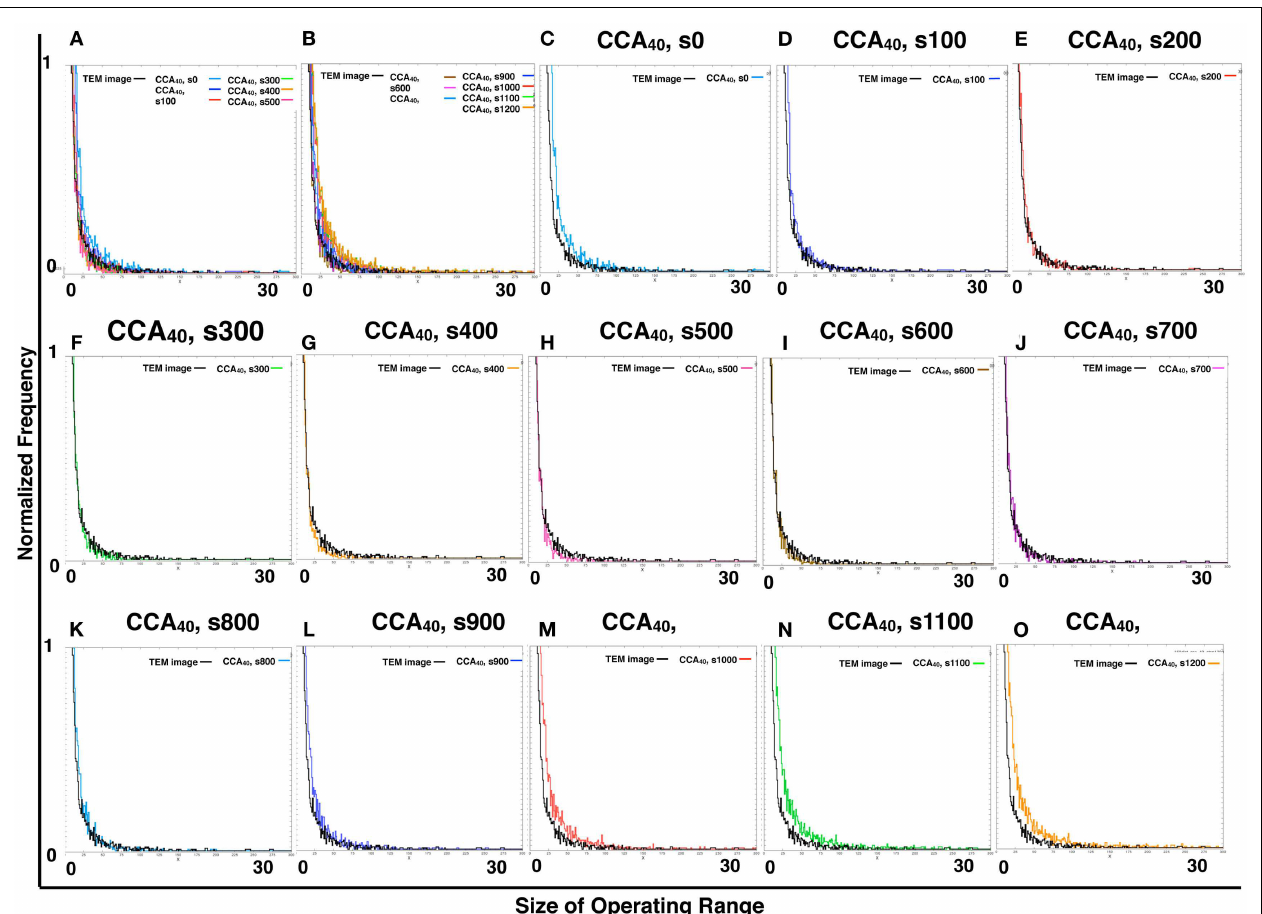
the size distribution of the operating range ofTEM images (black lines). x -Axes show the size of the operating range (0–300). y -Axes show the normalized frequency (0–1). (C–O) Show only two lines in one panel: the size distribution of operating range of one of the model among CCA 40 , s0–s1200, and aTEM image. Results in (C–E) show the cases of preliminary CCA. Results in (F–K) show the cases of early CCA.The results in (L–O) show the cases of completed